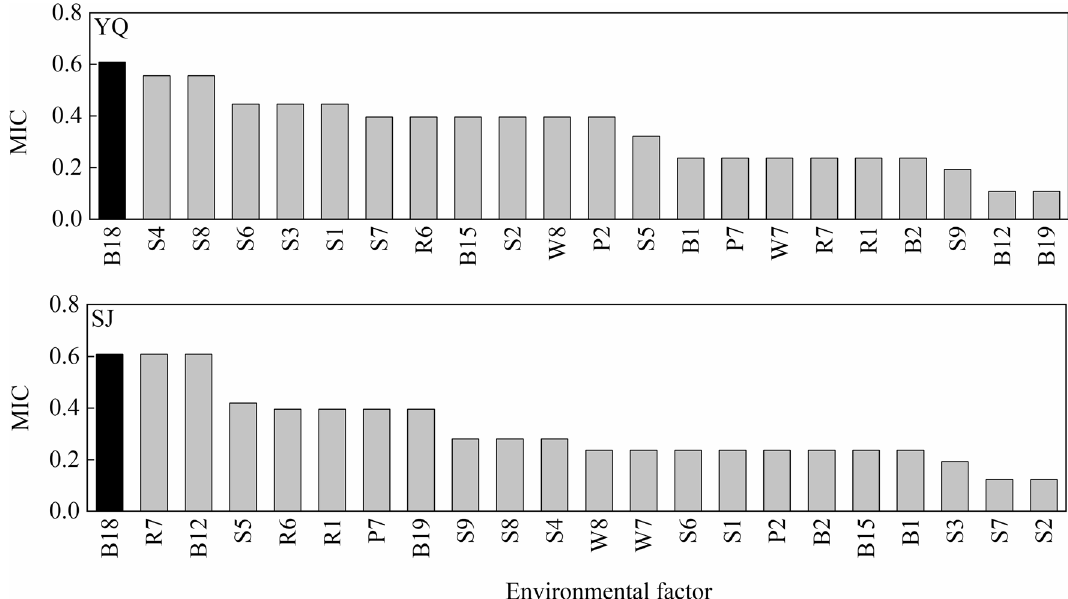
Figure 5. MIC correlation coefficient of Quercus liaotungensis seedlings between PI total and environmental factor. YQ represents the Yangqu test site, and SJ represents the Sanjiao test site. See Table 3 for the meaning of environmental factor code. Black bars indicate the same environmental factor with the highest MIC between test sites.